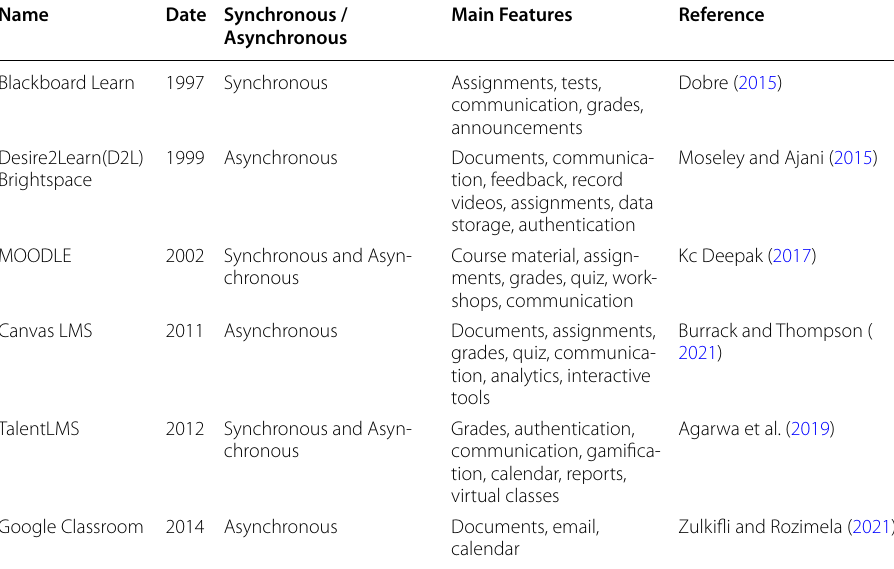
Table 6 Typical E-learning platforms used in education